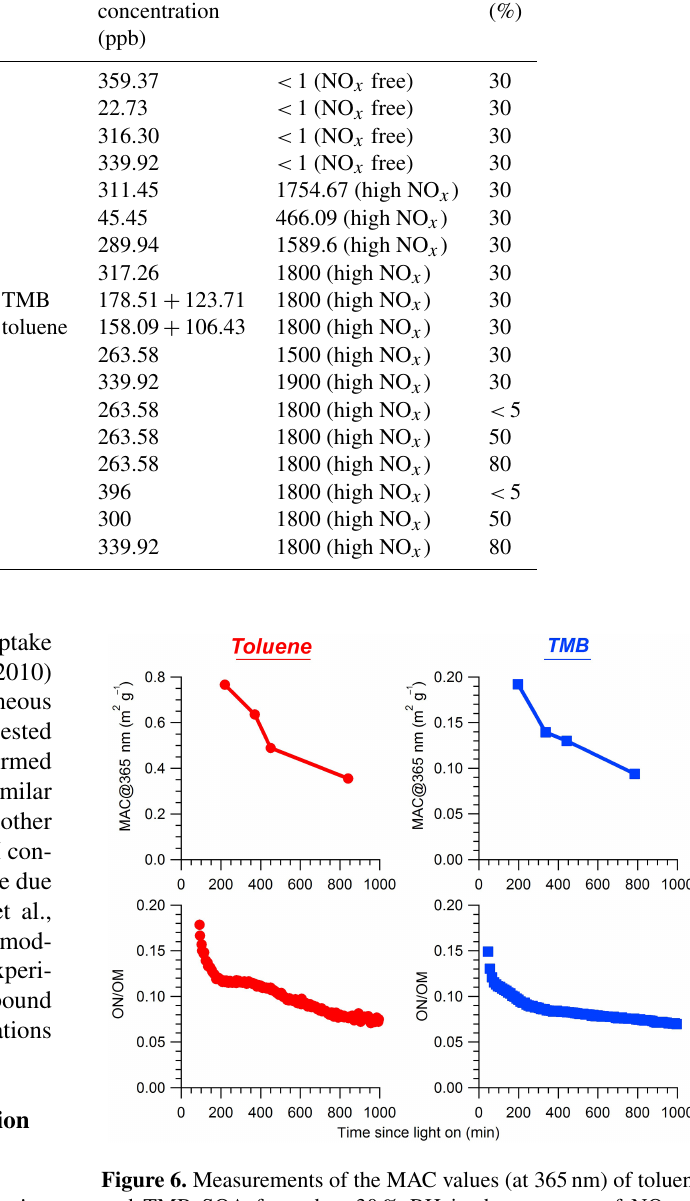
Table 1. Summary of experiments and experimental conditions described in this work. Experiment Experiment